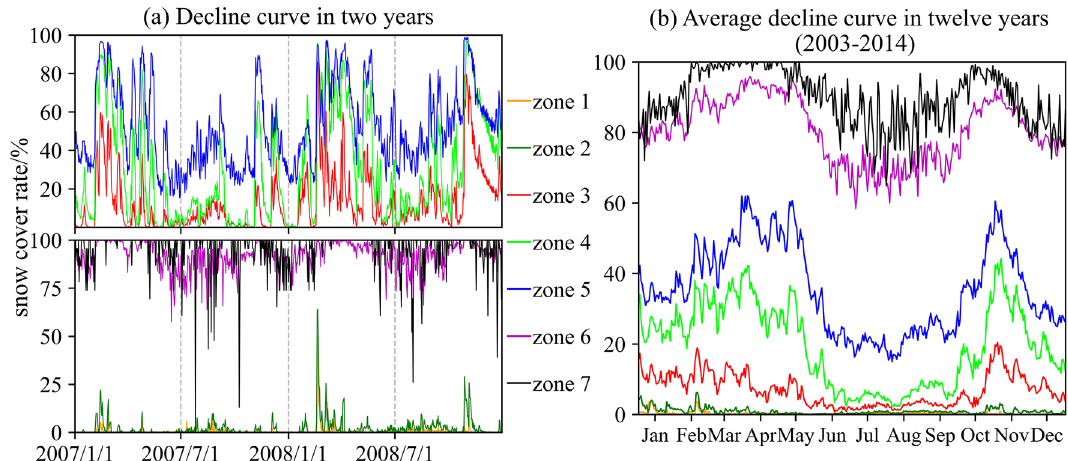
Figure 7. Decline curves of elevation zones. Taking each elevation zone as a unit, the decline curves are made of the daily ratio that snow cover area accounts for the elevation zone area. In ( a ) shows an example of the snow cover area ratio variation on a daily scale between January 1, 2007, and December 31, 2008. By ignoring the ratio of the last day of the intercalary month between January 1, 2003, and December 31, 2014, the average decline curve is computed based on the decline curves of 12 different years for each elevation zone, as shown in ( b